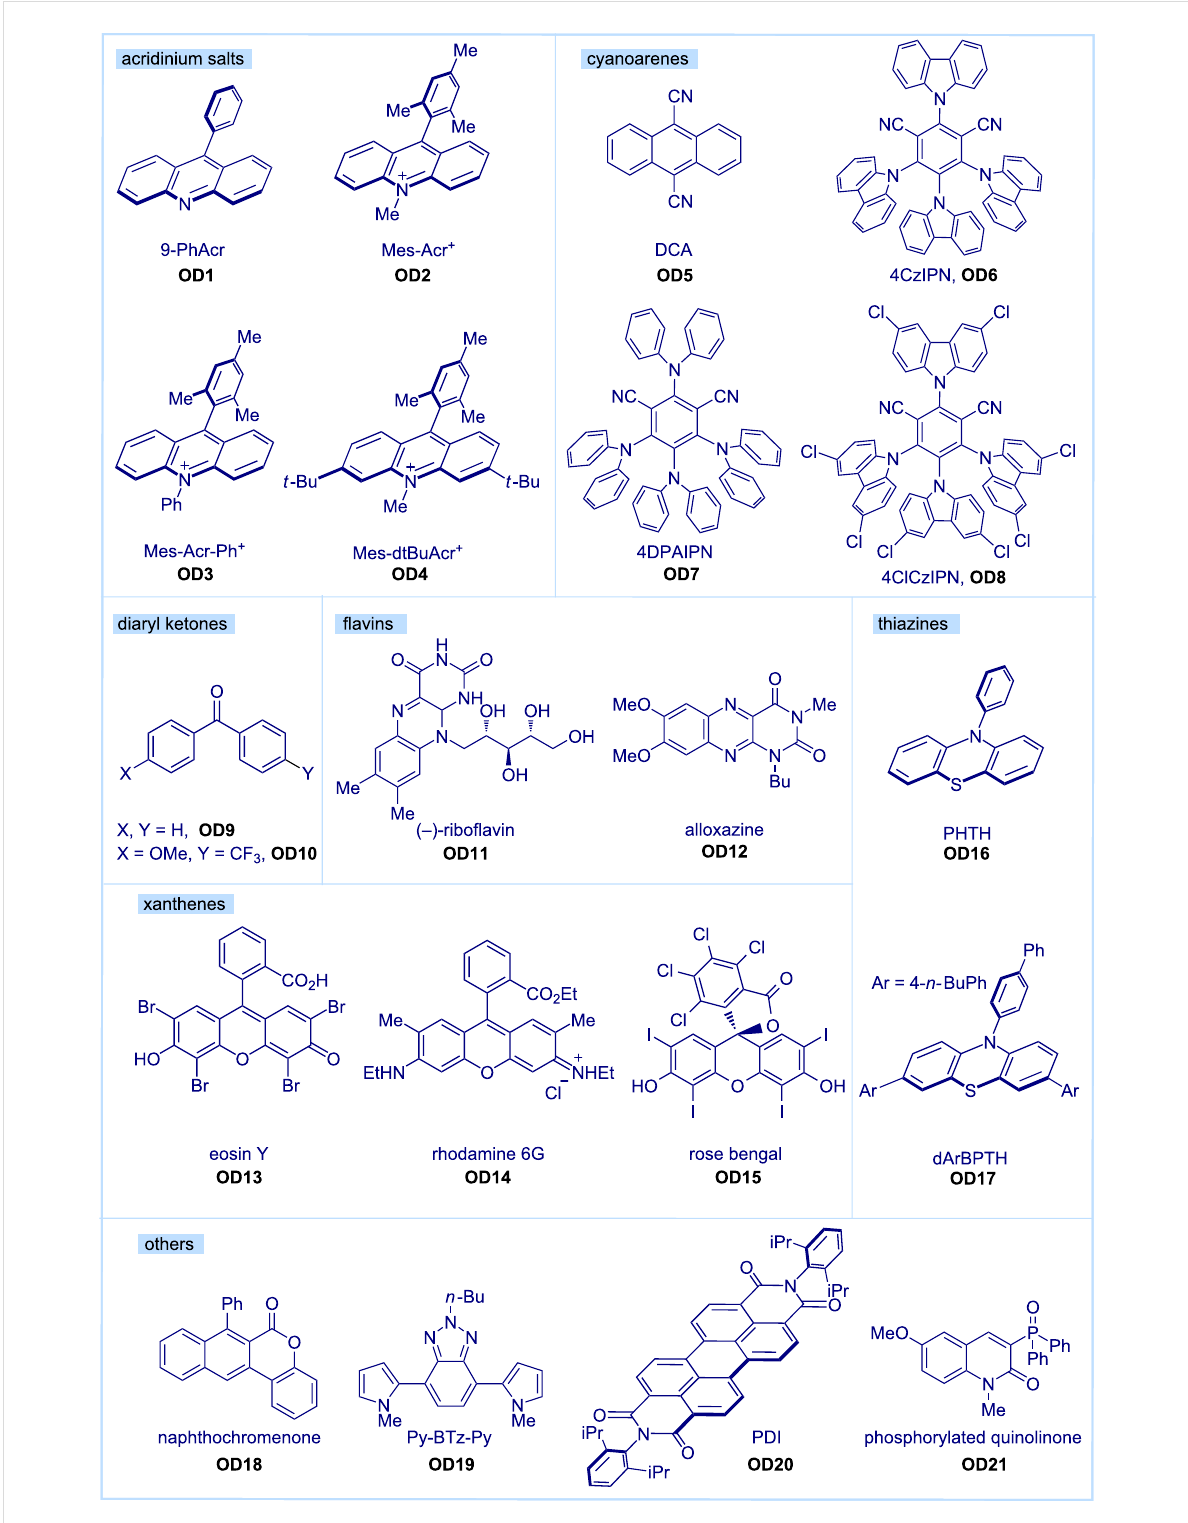
Figure 1: Selected examples of organic dyes. Mes-Acr + : 9-mesityl-10-methylacridinium, DCA: 9,10-dicyanoanthracene, 4CzIPN: 1,2,3,5- tetrakis(carbazol-9-yl)-4,6-dicyanobenzene, 4DPAIPN: 1,3-dicyano-2,4,5,6-tetrakis( N , N -diphenylamino)benzene, PHTH: 10-phenylphenothiazine, dArBPTH: 10-([1,1'-biphenyl]-4-yl)-3,7-bis(4-butylphenyl)-10 H -phenothiazine, Py-BTz-Py: butyl-4,7-bis(1-methyl-1 H -pyrrol-2-yl)-2 H -benzo[ d ][1,2,3]tri- azole, PDI: N , N